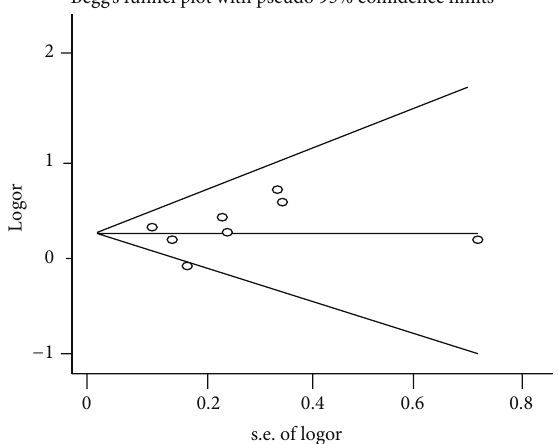
Figure 4: Funnel plot of the association between the self-reported habitual snoring and diabetes mellitus